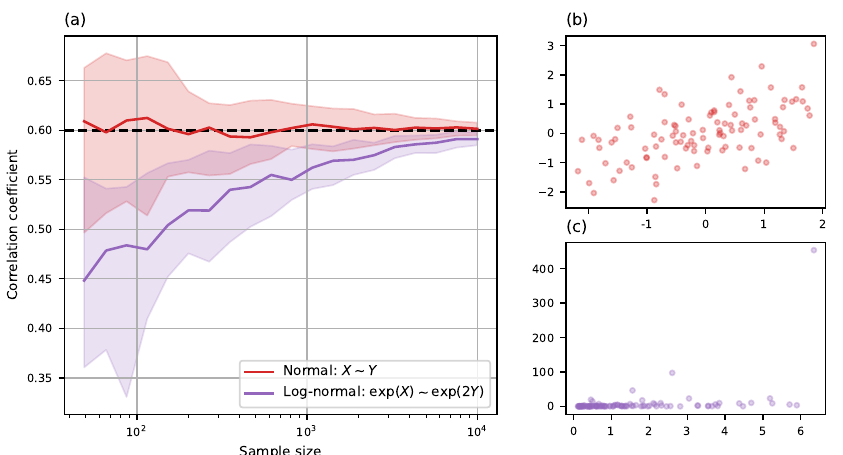
Figure 4. ( a ) Median and interquartile range of MI correlation coefficient as the sample size increases. The bottom line is of two log-normal variables; the top line of the same variables after a log transform is much closer to the real ρ = 0.6. ( b ) A sample from the correlated normal distributions of X and Y values is quite symmetric. ( c ) The corresponding log-normal distribution of the values exp ( X ) and exp ( 2 Y ) is concentrated near the origin but has many far-away points, as illustrated by the larger axis range (maximal y ≈ exp ( 2 × 3 ) ≈ 400).